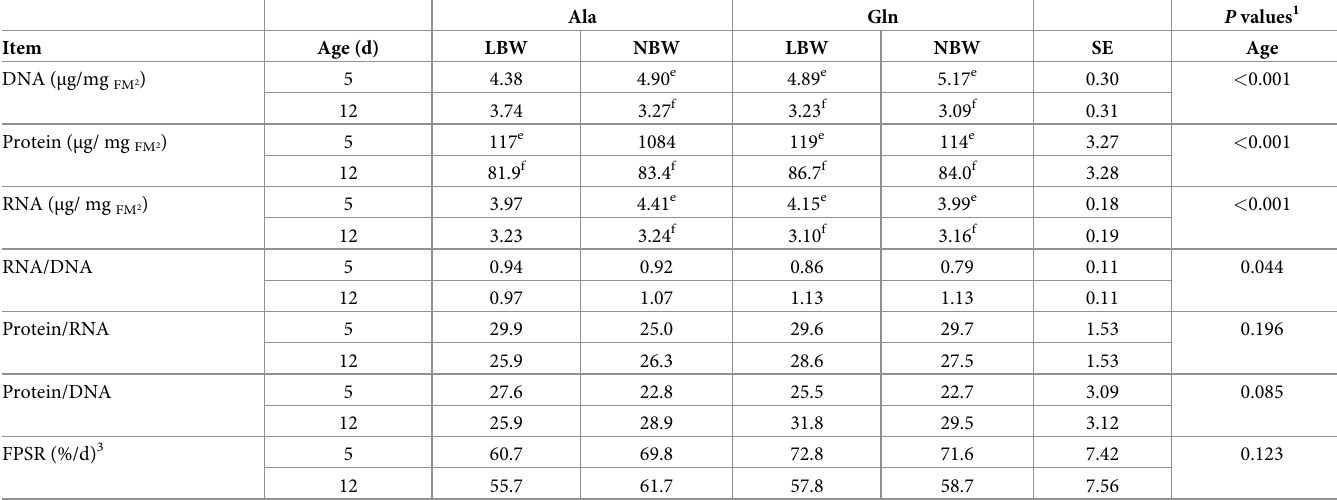
Table 3. Jejunal biochemical indices in low and normal birth weight male suckling